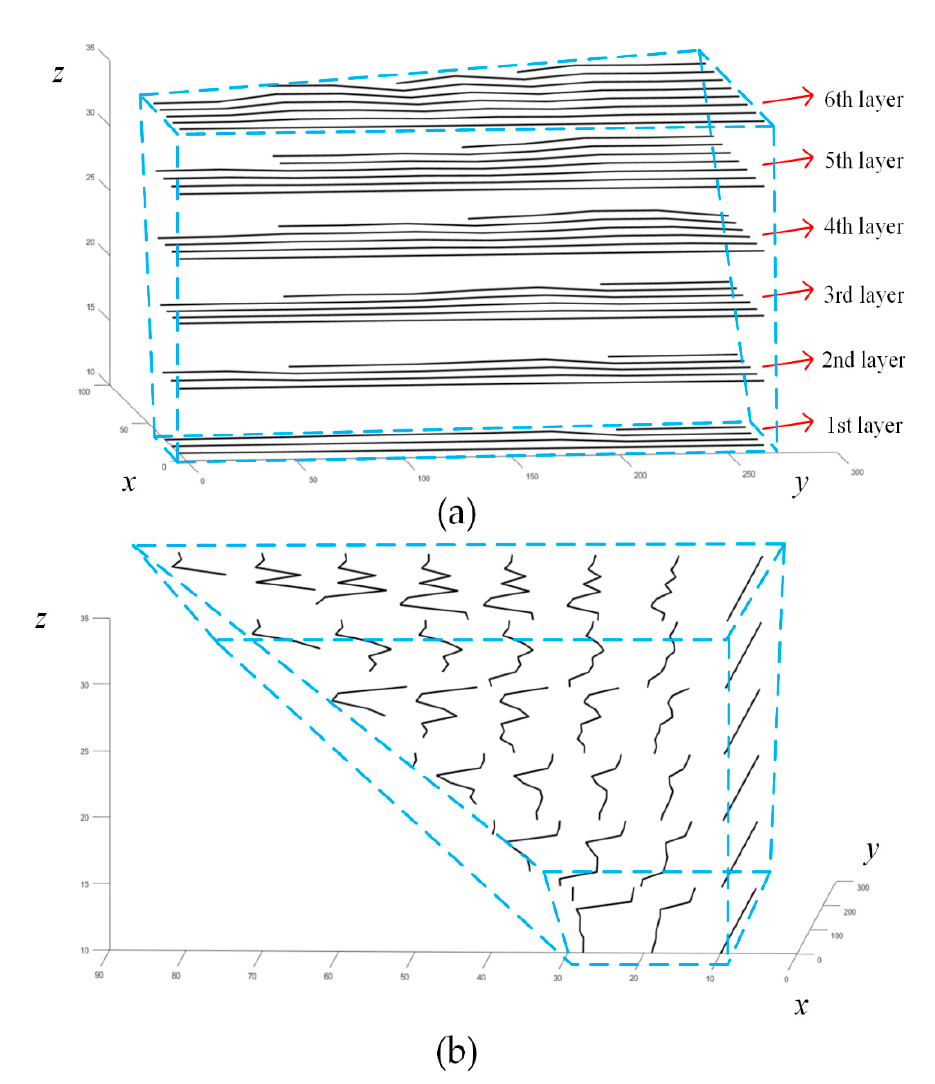
Figure 21. ( a ) Simulation results of path generation (the blue part is the groove outline); ( b ) Simulation results of path generation in section direction.